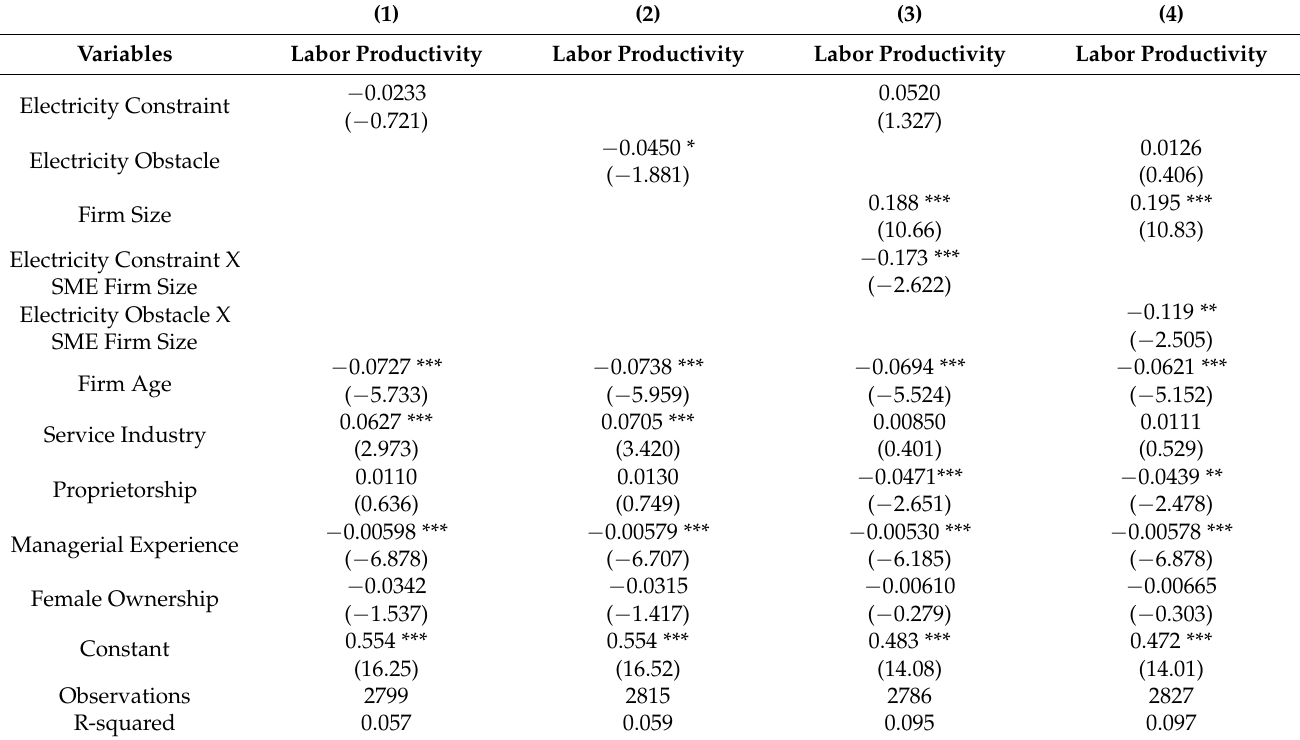
Table 5. Impact of access to electricity on labor productivity with interaction effect of firm